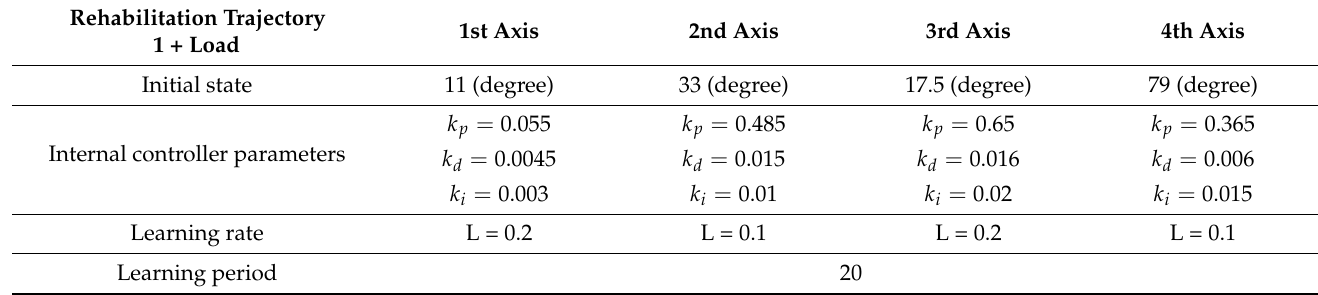
Table 9. Trajectory 1 (load-on) ILC controller parameters table.